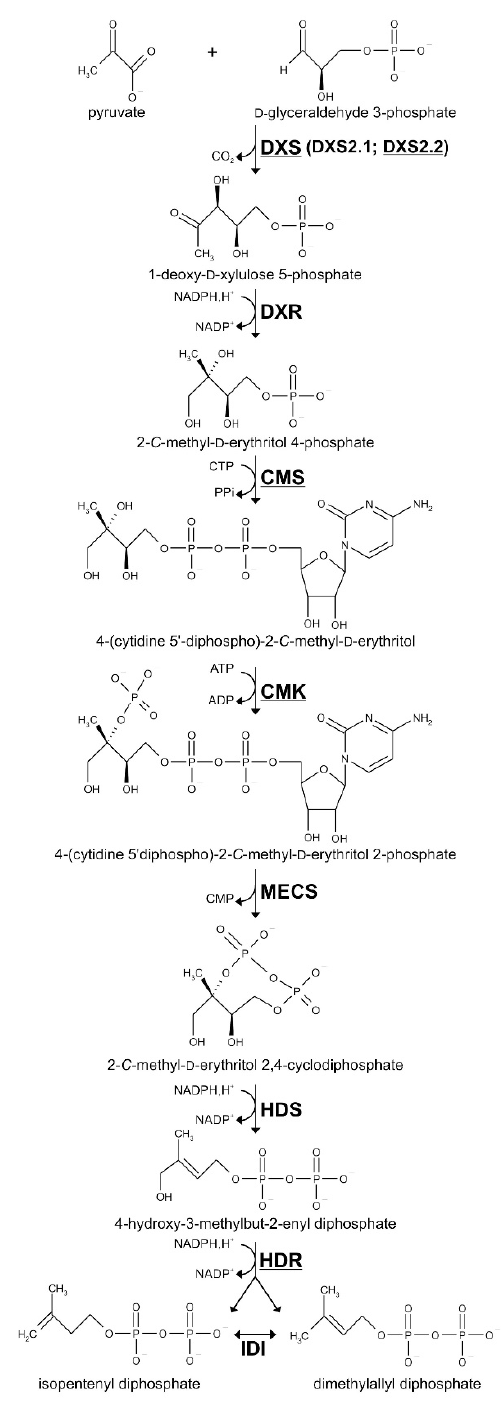
Figure 1. The 2- C -methyl-D-erythritol 4-phosphate (MEP) pathway yielding isopentenyl diphosphate (IPP) and its allylic isomer dimethylallyl diphosphate (DMAPP). DXS, 1-deoxy-D-xylulose 5-phosphate synthase; DXR, 1-deoxy-D-xylulose 5-phosphate reductoisomerase; CMS, 2- C -methyl-D-erythritol 4-phosphate synthase; CMK, 4-(cytidine 5 ′ diphospho)-2- C -methyl-D-erythritol kinase; MECS, 2- C -methyl-D-erythritol 2,4-cyclodiphosphate synthase; HDS, ( E )-4-hydroxy-3-methylbut-2-enyl diphosphate synthase; HDR, ( E )-4-hydroxy-3-methylbut-2-enyl diphosphate reductase; IDI, isopentenyl diphosphate isomerase. DXS2.1 and DXS2.2 correspond to class II DXS isoforms. cDNA characterized in this work are underlined. This metabolic intermediate is phosphorylated by CDP-ME kinase (CMK) to form CDP-